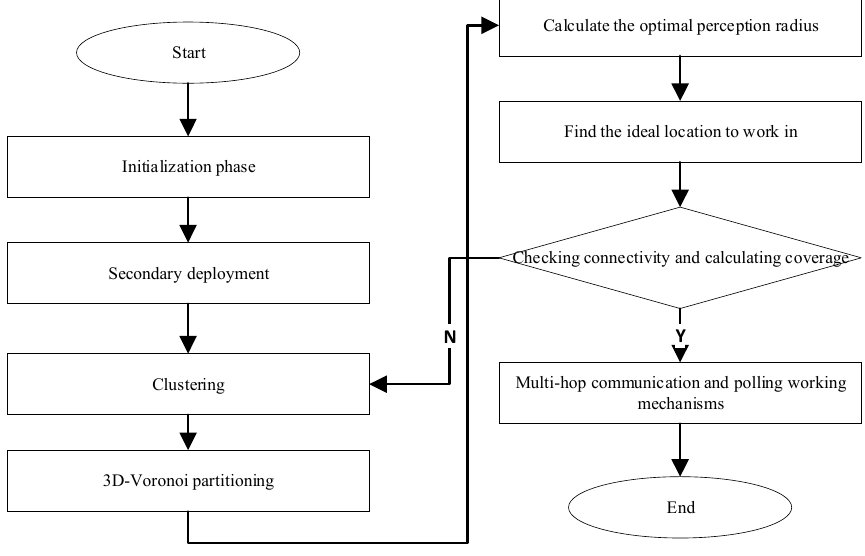
Figure 6. VKECE-3D algorithm flowchart.